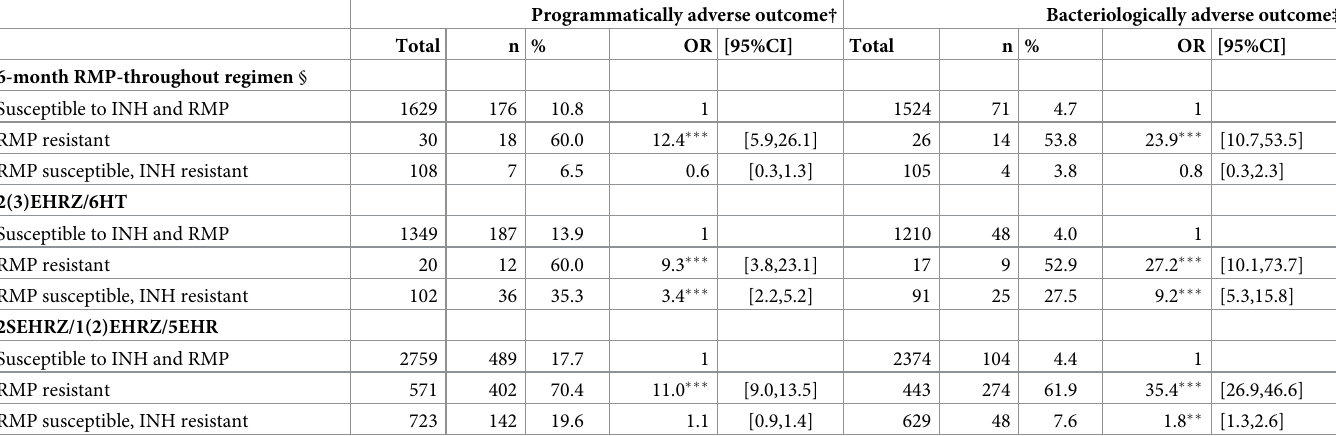
Table 3. Effect of initial resistance on outcomes, by treatment regimen, in 7291 patients.